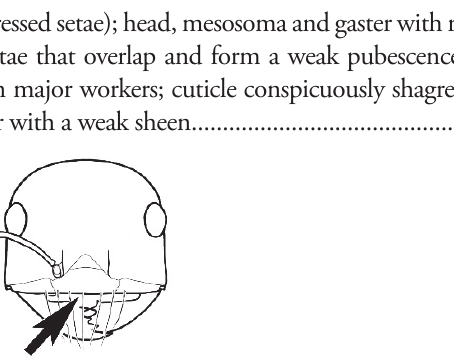
– Clypeus variable in appearance (flattened or weakly protuberant or depressed anteriorly) but not distinctly folded back as above; head, mesosoma and gaster with short, inconspicuous appressed setae that are usually separated by more than their own length on the gaster (if more elongate, as in some small minor workers, then ant is glossy and weakly sculptured) ......................... 96 95 Ant uniformly brown; minor worker smaller (HW ≈ 0.70 mm) (NT, northern WA) ( JDM 951 ) (Fig. 83a–g) .................................................. parvimolaris